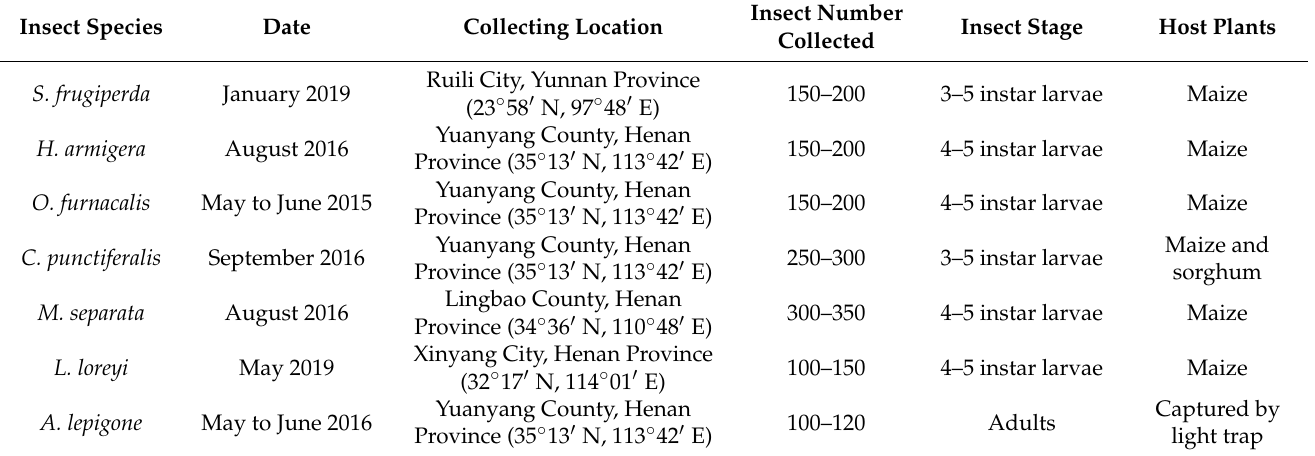
Table 2. Source information of tested